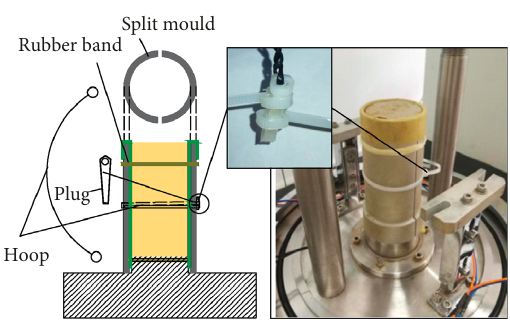
Figure 12: Schematic diagram of process ② .